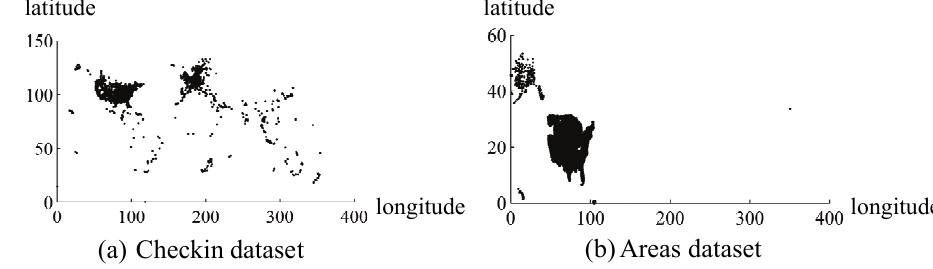
Figure 4. Illustration of